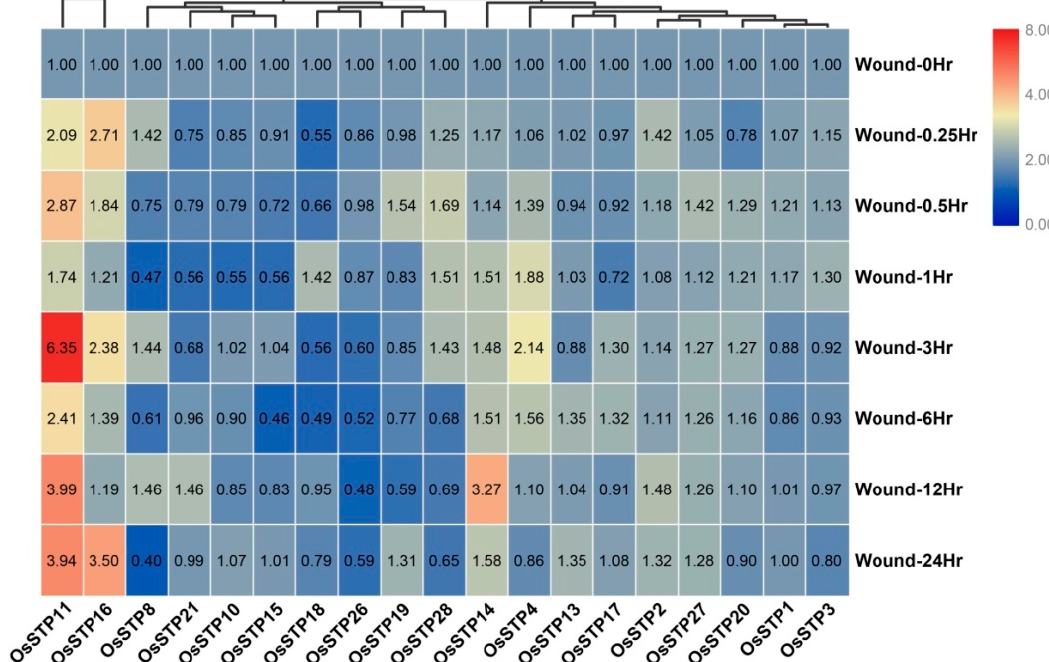
Figure 7. Expression changes of the rice seedling after wounding. Wound-0Hr, Wound-0.25Hr, Wound-0.5Hr, Wound-1Hr, Wound-3Hr, Wound-6Hr, Wound-12Hr, and Wound-24Hr mean 0, 0.25, 0.5, 1, 3, 6, 12, and 24 hours after wounding. The color scale represents fold changes and is the same as Figure 6.